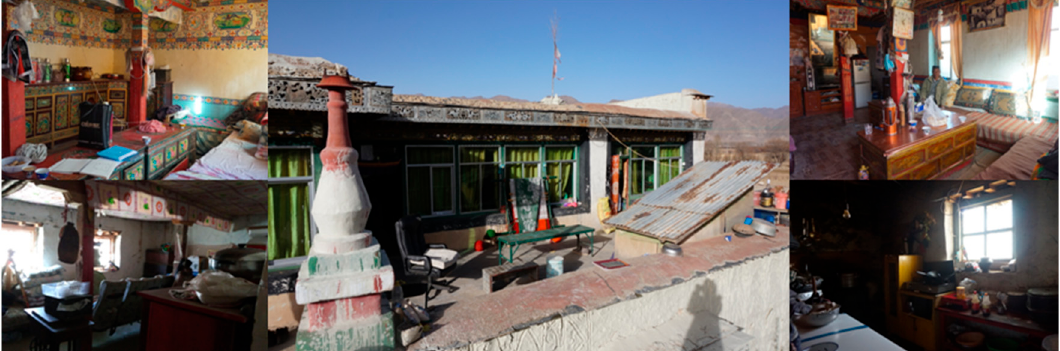
Figure 1. Images of the measured rural building in Tibet.